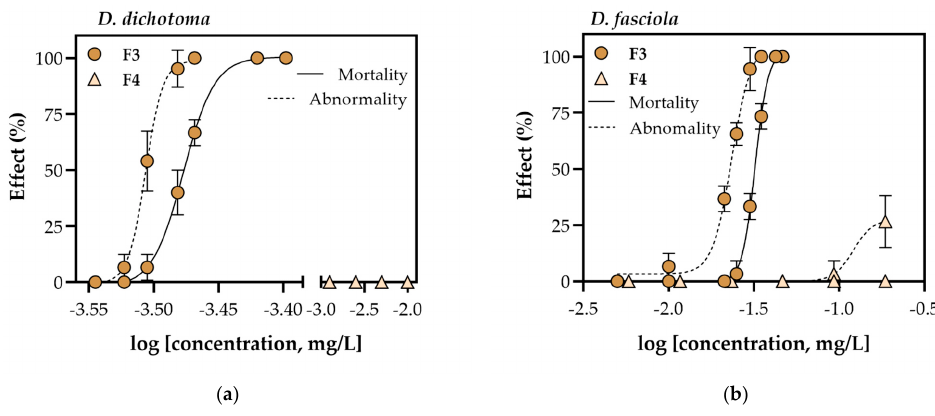
Figure 2. Dose–response curves showing cumulative mortality and developmental abnormality of zebrafish D. rerio at 96 h of exposure to two fractions (F3 and F4) of ( b ) D. fasciola and ( a ) D. dichotoma . Error bars indicate standard deviations (SD).